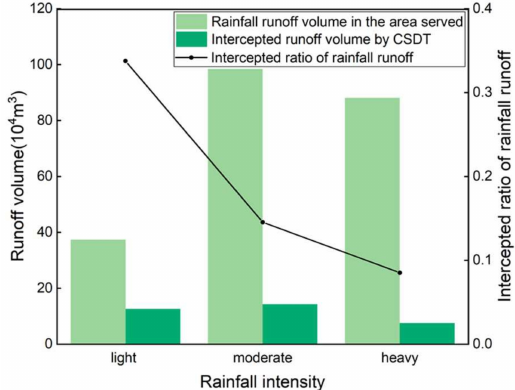
Figure 8. Combined sewer detention tank (CSDT) performances under different rainfall intensities and the ratio of intercepted rainfall runoff in the area served by the CSDTs (solid circles) in